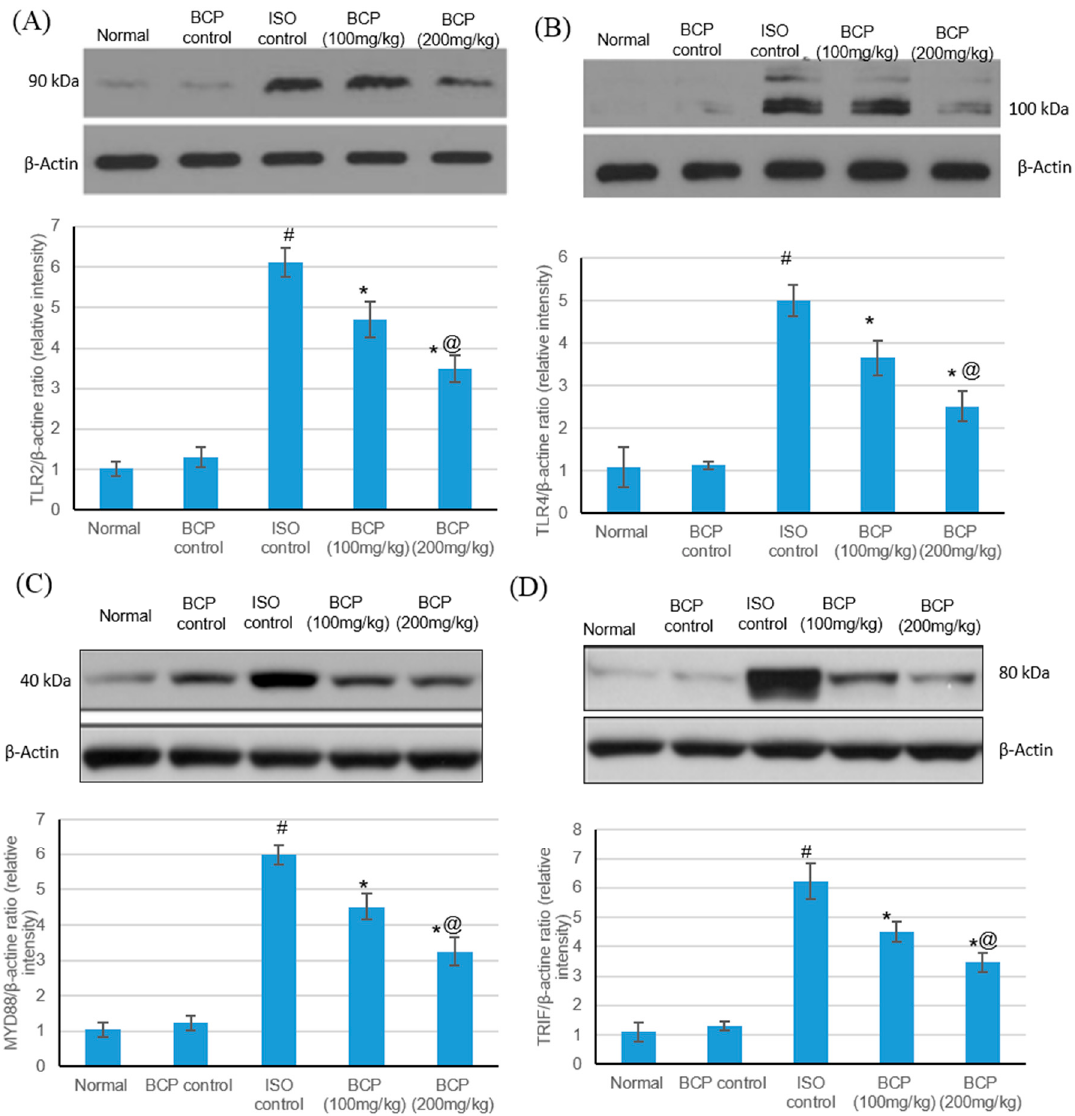
Figure 7. Effects of β -caryophyllene treatment (100, 200 mg/kg) for 21 days on TLR pathway